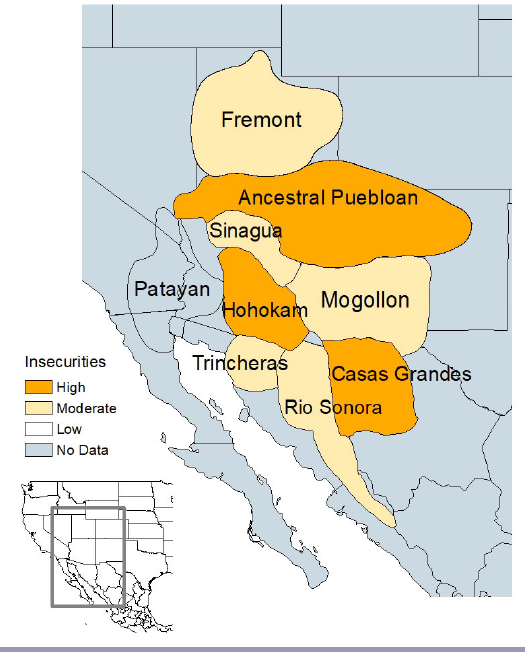
Fig. 6 . Personal insecurity prior to depopulation (indicator: increasing conflict and violence).